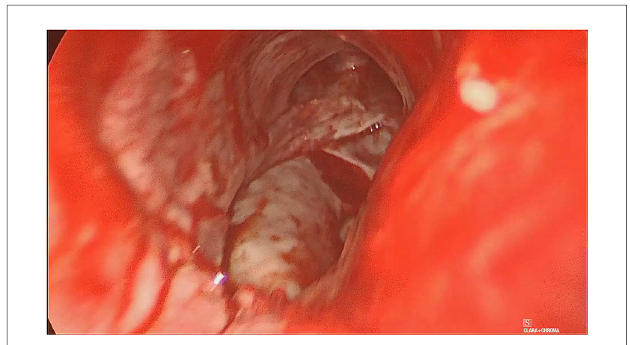
FIGURE 1 Lesion of the pars membranacea extending from 5 cm from the glottis up to carena, including the origin of the main right bronchus. Bulging of the anterior esophageal wall is visible through the loss of trachea